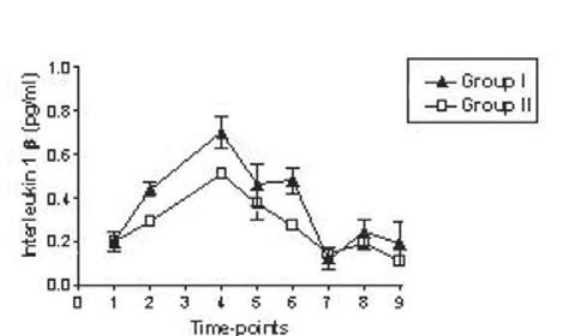
Fig. 3 - Interleukin 1-â values over time. Group 1 - no ultrafiltration; Group II - with ultrafiltration. * statistically